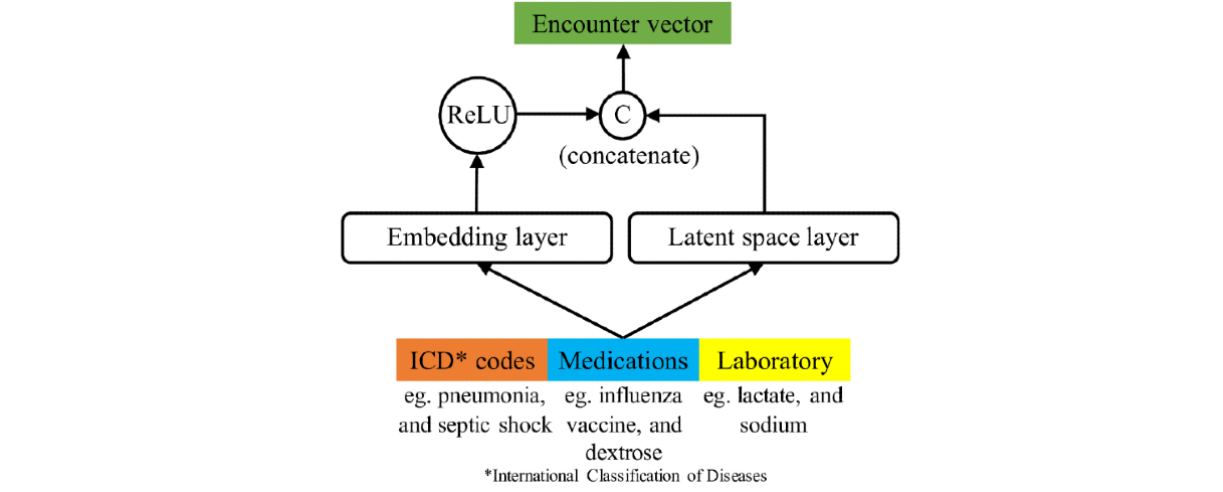
Figure 2. Model for constructing the encounter vector. ReLU: rectified linear unit; ICD: International Classification of Diseases.